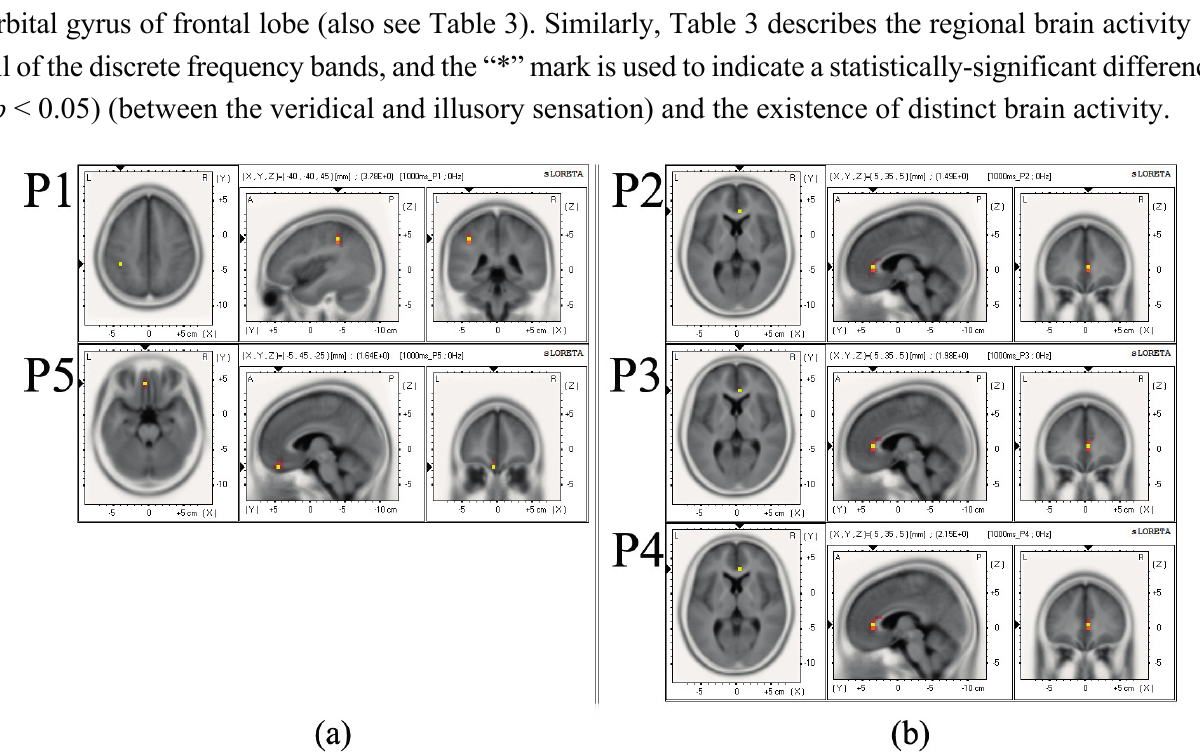
Figure 8. Brain activation areas in the delta band frequency: ( a ) veridical (at P1, P5); and ( b ) illusory (at P2–P4). The activation of a subject mapped in a sLORETA (standard low resolution brain electromagnetic tomography) generic brain template is